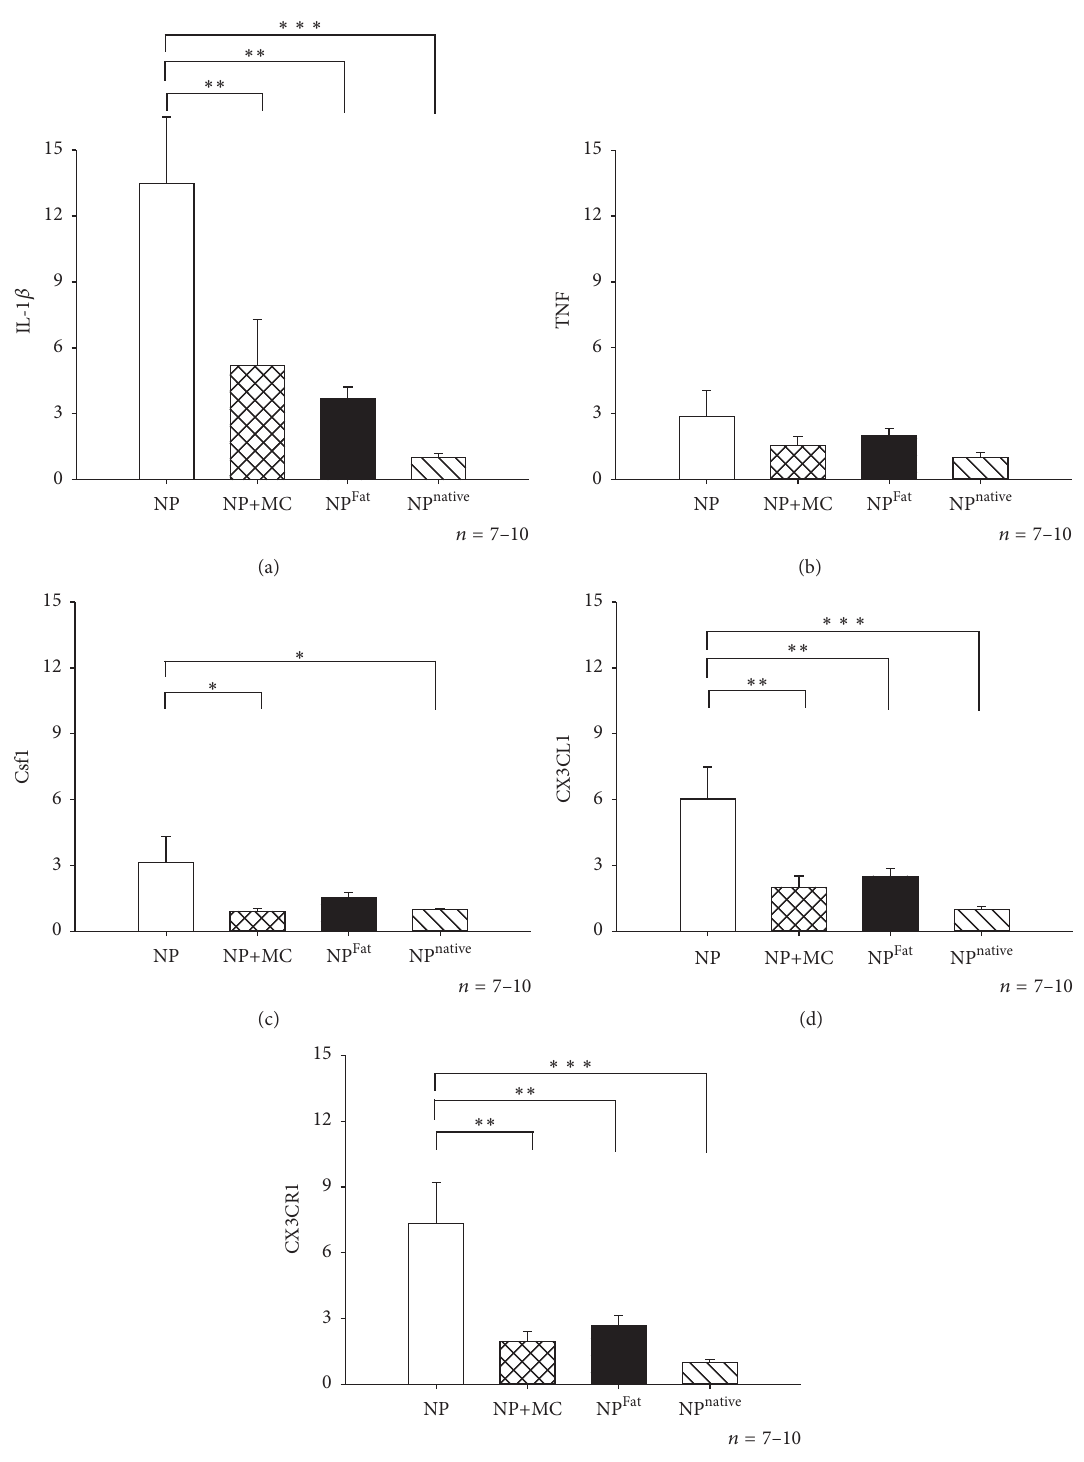
Figure 3: Fold expression of (a) IL-1 𝛽 , (b) TNF, (c) Csf1, (d) CX3CL1, and (e) CX3CR1 in NP in the three groups: NP in contact with dorsal nerve roots for 180 minutes (NP), NP in contact with dorsal nerve roots for 180 minutes together with minocycline (NP+MC), NP in contact with neck fat tissue for 180 minutes (NP Fat ), and native nucleus pulposus (NP native ). ∗ 𝑃 < 0.05 , ∗∗ 𝑃 < 0.01 , ∗∗∗ 𝑃 < 0.001 , one-way ANOVA, Tukey’s post hoc